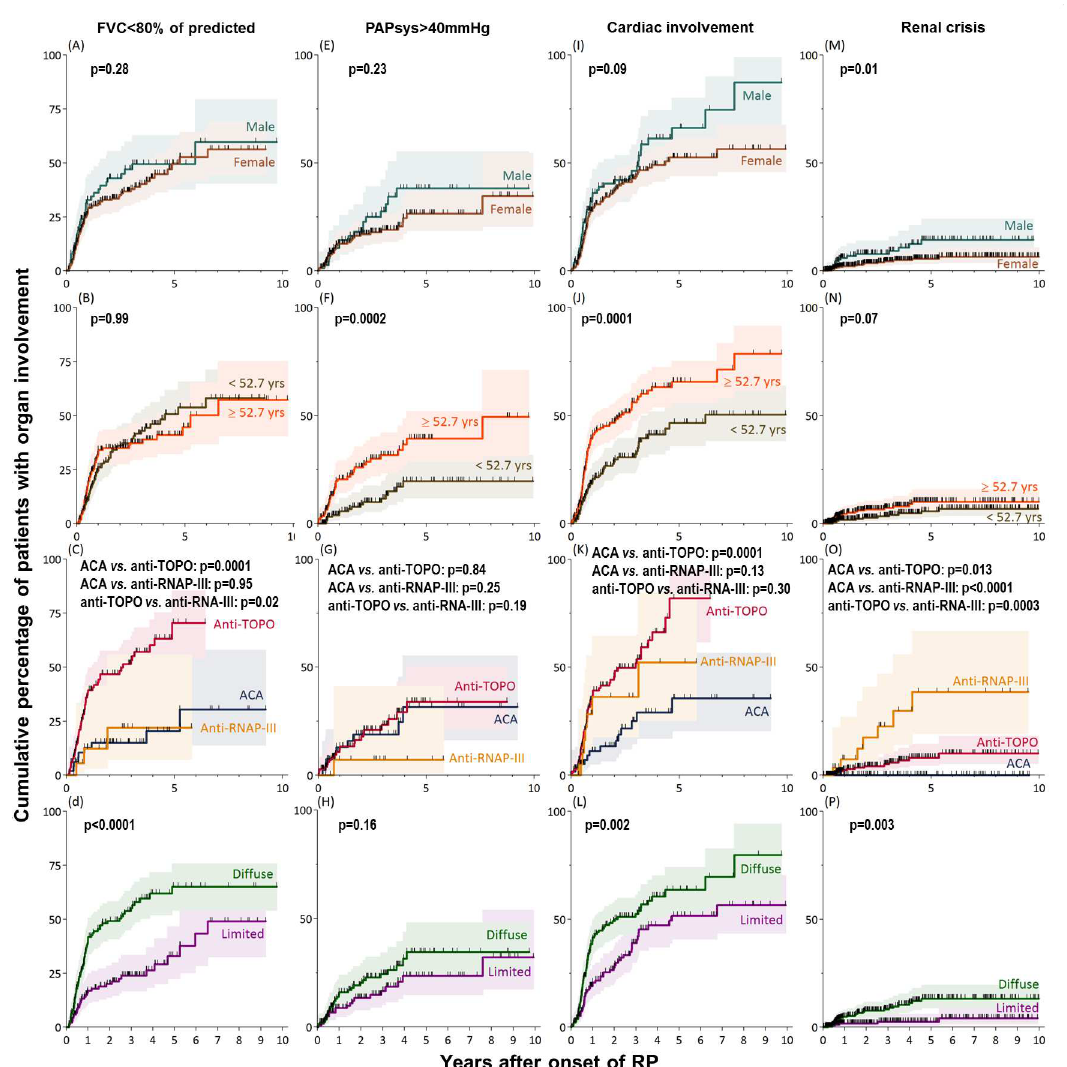
Fig 4. Kaplan-Meier curves with 95% CI of incident pulmonary restriction (FVC < 80% of predicted; (A-D)), suspected pulmonary hypertension (PAPsys > 40 mmHg; (E-H)), cardiac involvement (I-L) and renal crisis (M-P) after RP onset in SSc patients of the study population; stratified by sex (A/E/I/M), the median age at RP onset (B/F/J/N), autoantibody status (C/G/K/O) and extent of skin involvement within the first year after RP onset (D/H/L/P). CI, confidence interval; FVC, forced vital capacity; PAPsys, systolic pulmonary artery pressure as estimated by echocardiography; cardiac involvement, defined as either the presence of diastolicdysfunction, conductionblocks, a left ventricularejection fraction (LVEF) < 50%, or a pericardialeffusion; RP, Raynaud’s phenomenon; yrs, years; ACA, anti-centromereautoantibodies; Anti-TOPO, Anti-topoisomerase-I autoantibodies; Anti-RNAP-III, anti-RNA-polymerase-III autoantibodies; hash marks represent censored